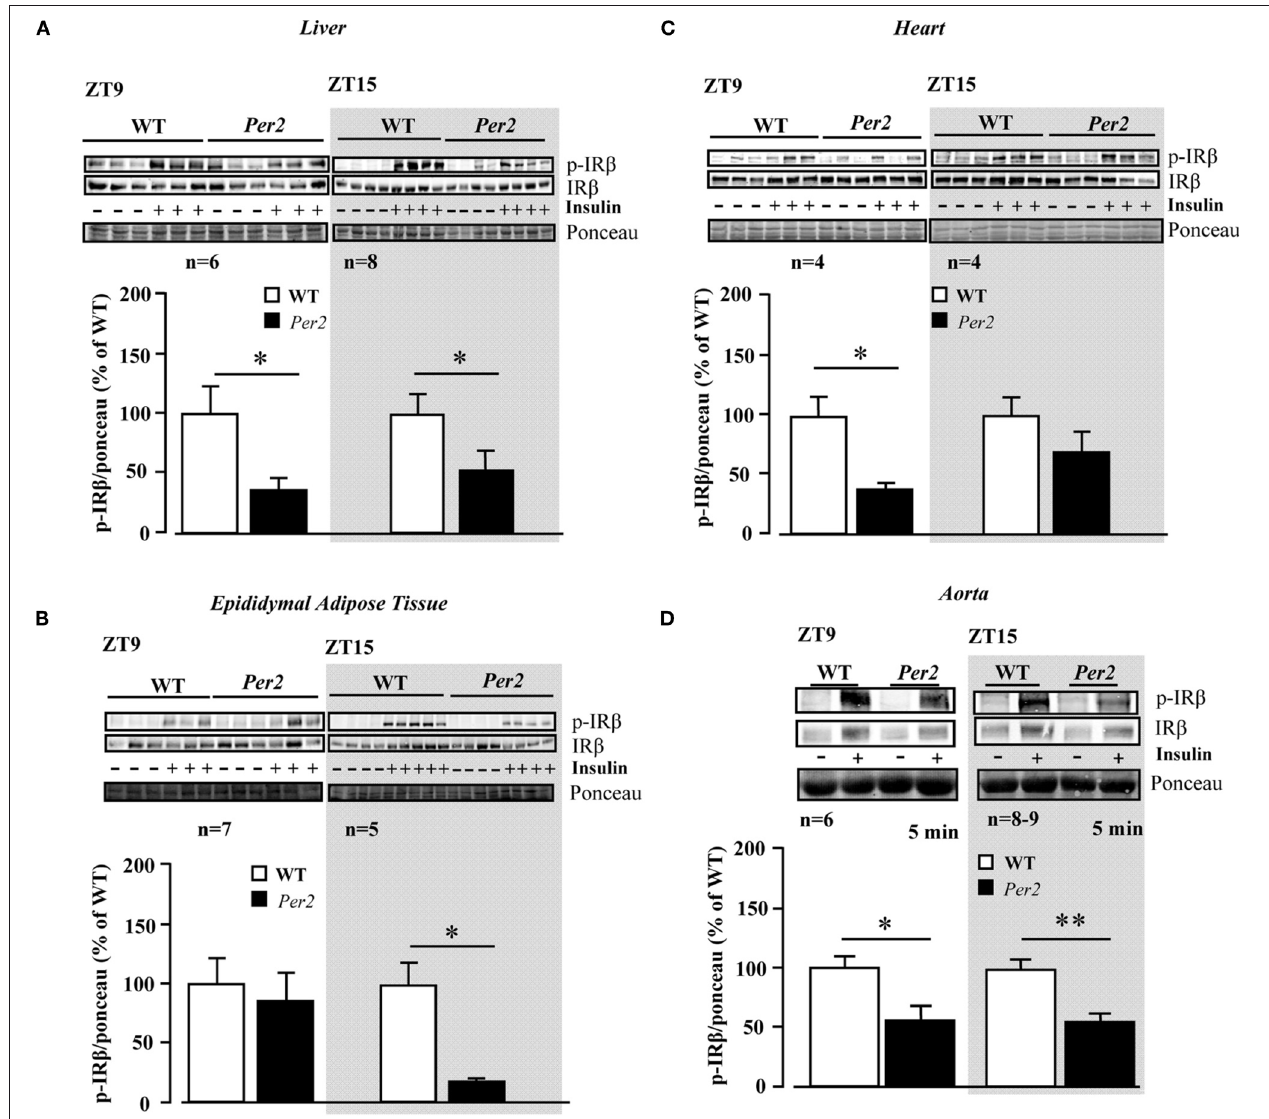
FIGURE 1 | Compromised insulin receptor activation in response to insulin in the liver (A), epididymal adipose tissue (B), heart (C), and aortas (D) of mPer2 Brdm1 mice. Representative immunoblotting and respective quantifications of insulin receptor β subunit phosphorylations (Y1162/1163)upon intraperitoneal injection of insulin (0.5mU/g body